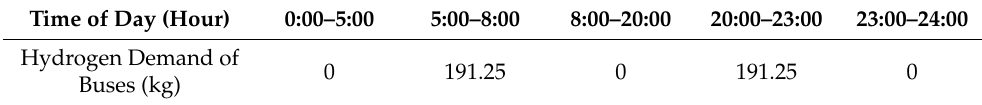
Figure 5. Hydrogen demand estimation results and actual demand values, except for buses. Table 2. Hydrogen demand of buses with presented dispatching